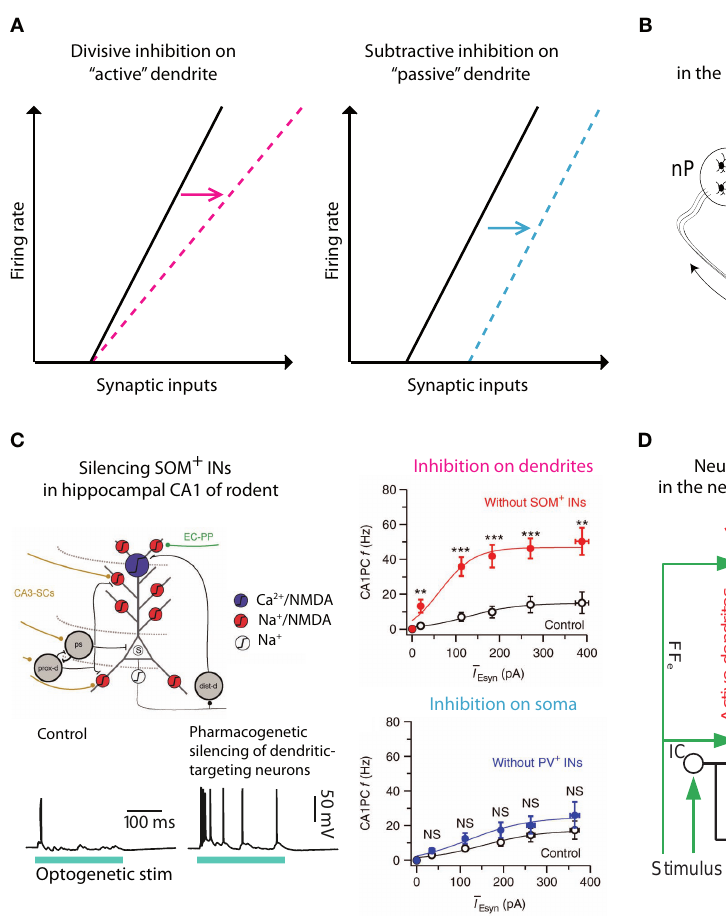
2005). (C) Similarly, in the mammalian hippocampus, synaptic input is segregated on the dendritic trees of CA1 neurons where dendritic targeting somatostatin-positive inhibitory neurons have been shown to perform gain modulation whereas more proximal parvalbumin-positive neurons have negligible effect on gain. Adapted from (Lovett-Barron et al., 2012). (D) A similar effect of dendritic targeting,